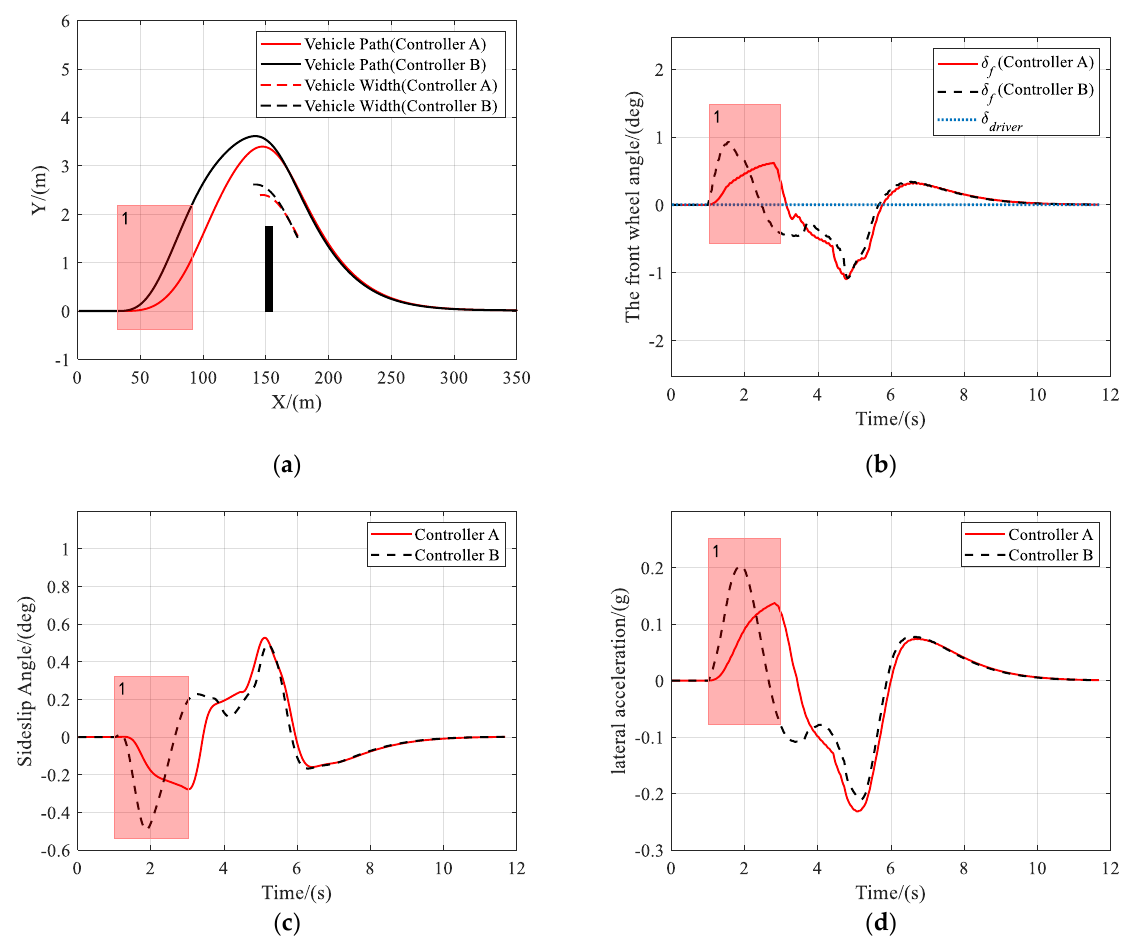
Figure 7. Scenario 1: Simulation results at 108 km/h. ( a ) Vehicle trajectory, ( b ) the actual front wheel angle, ( c ) sideslip angle, and ( d ) lateral acceleration.